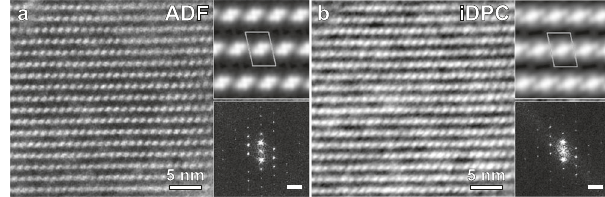
(1) ordered domains with a c -axis of 17 Å with a single layer